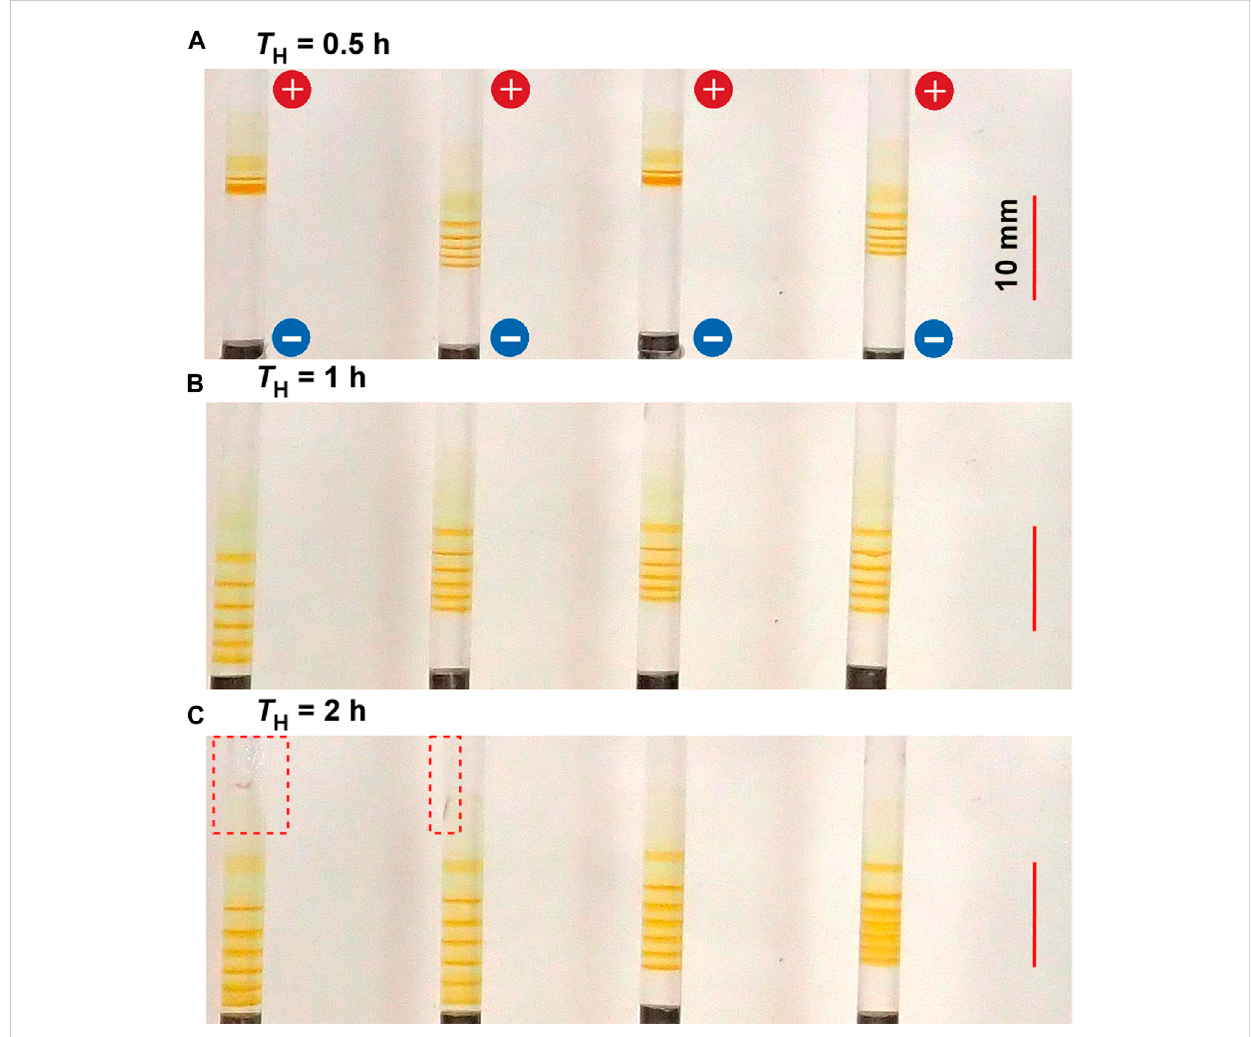
FIGURE 6 Typical periodic bands formed in the four gel columns with L = 50 mm at 25 ° C under the T H values (A) 0.5 (B) 1, and (C) 2 h. Here, E H = 3 V, E L = 1 V, T N L = 4 h, and C = 8 are kept constant. The scale bars are provided on the right parts of the images, and the charges of the electrodes are provided in the top image. The red broken squares enclose the area where the gel columns are